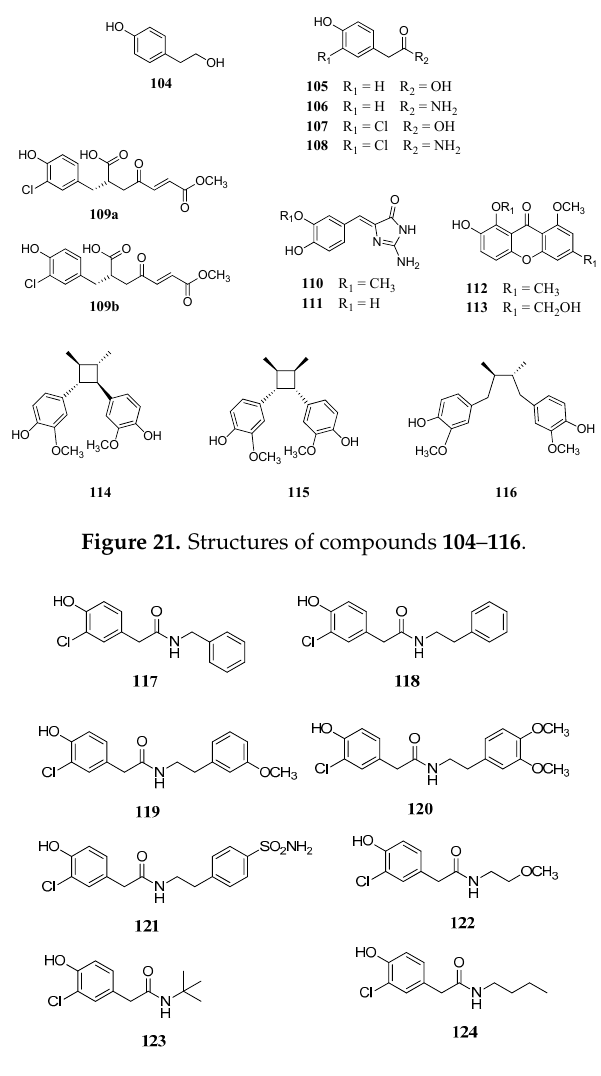
Figure 22. Structures of synthetic derivatives 117 – 124 .